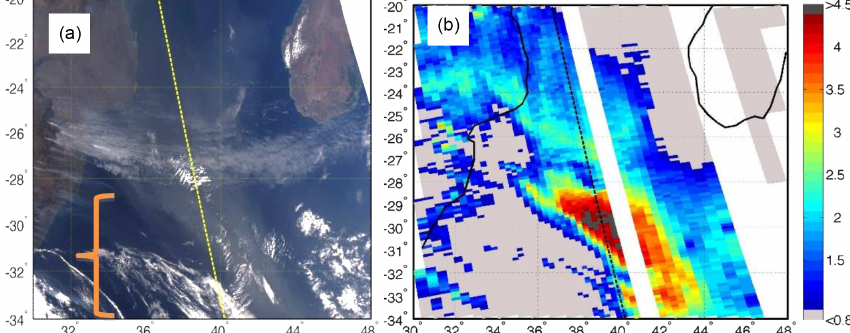
Figure 8. A case of thick smoke over the ocean as seen by OMI and MODIS (a) MODIS RGB image for 31 August 2008 (11:25UTC) off the coast of SE Africa. The yellow line is the CALIOP track and the bracket indicates the sector that is analyzed in detail in Fig. 10. (b) Corresponding OMI Aerosol Index (CALIOP track in black).